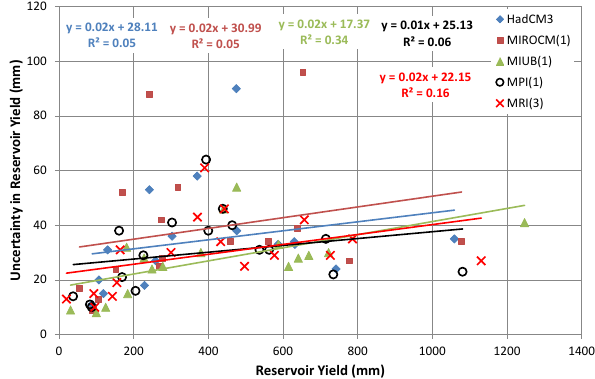
Figure 12. Box plots of average reservoir yield for the 30-year pe- riods 1965–1994 (20C3M) and 2015–2044 (A1B) for five GCMs. Reservoir yield is estimated using the Gould–Dincer Gamma reser- voir storage model for reservoir size τ = 3 × MAR and 95% relia- bility of draft. Runoff metrics for the Gould–Dincer Gamma method are estimated from 100 PERM runs of quantile–quantile bias- corrected stochastic replicates of GCM data for catchment 6058 – Herbert River at Gleneagle (Australia). The box represents the inter- quartile range and the whiskers extend to the maximum and mini- mum values. The Raw value next to each box plot represents the Gould–Dincer Gamma output when using the bias-corrected GCM runs that the stochastic replicates are based on.